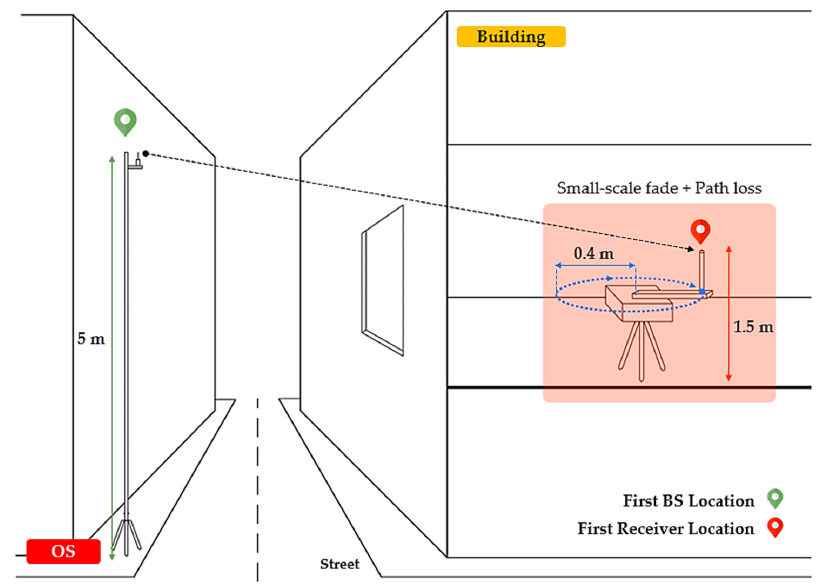
Figure 2. An example of the OS NLOS measurement configuration with the on-axis 0.4 m rotating system.